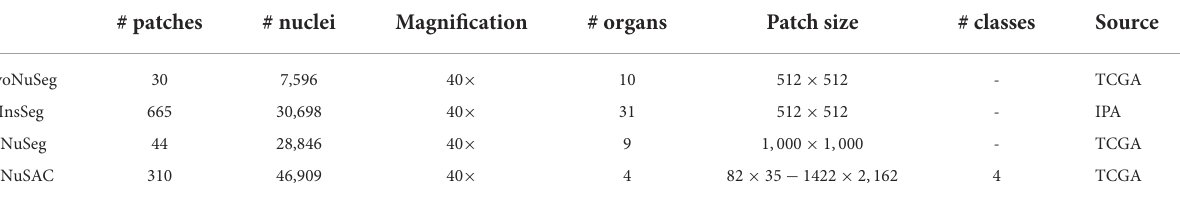
TABLE 1 Details of the utilized datasets.